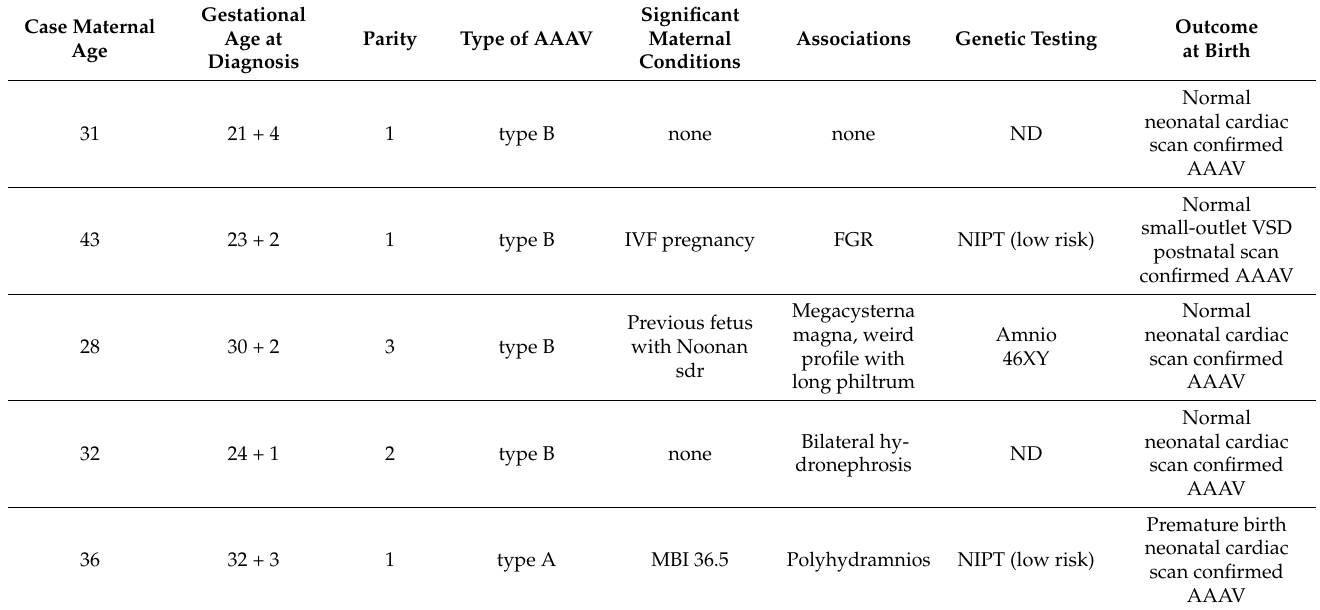
Table 1. The main characteristics of the pregnancies with fetal AAAV.